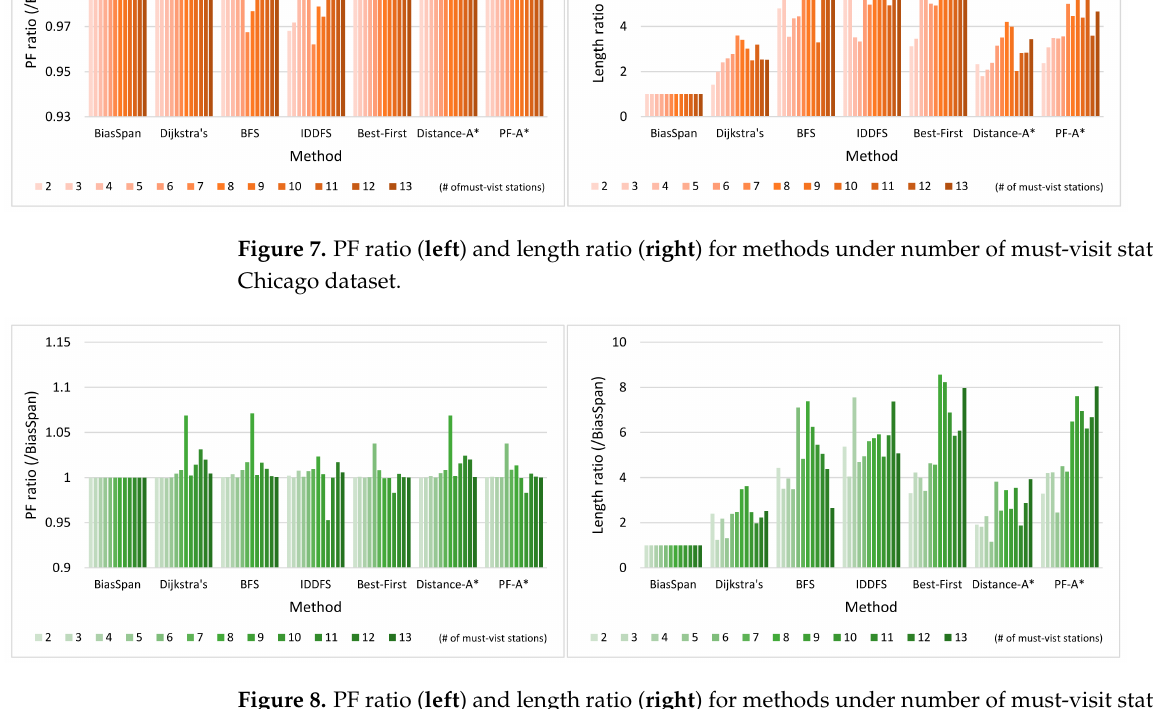
Figure 8. PF ratio ( left ) and length ratio ( right ) for methods under number of must-visit stations in Tainan dataset.